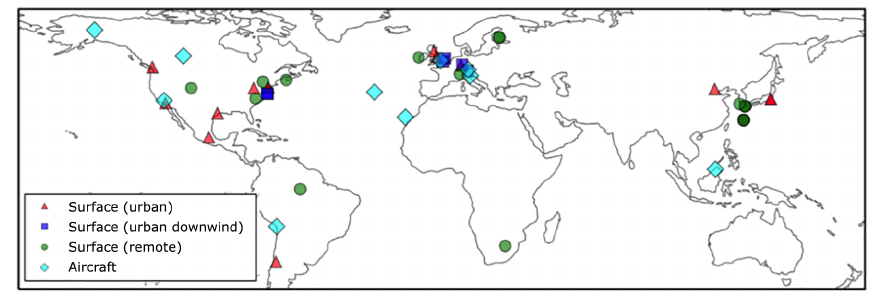
Figure 2. Global map showing the 40 surface AMS observations, originally compiled by Zhang et al. (2007) and classified as urban (red triangles), urban downwind (blue squares), or remote (green circles). Of the surface observations, 37 have been classified as hydrocarbon-like OA and oxygenated OA. Observations from 10 aircraft campaigns, originally compiled by Heald et al. (2011), are also shown (light-blue diamonds); these remain as total